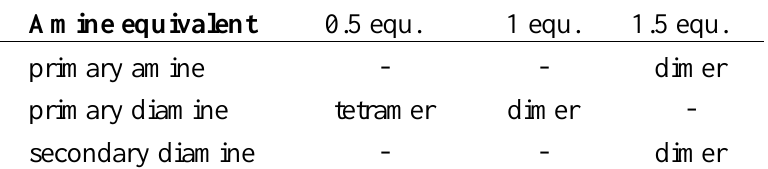
Table 1 : Proportions of amines and diamines used to prepared 6a-g , 7 , 8a-b and 9a-e